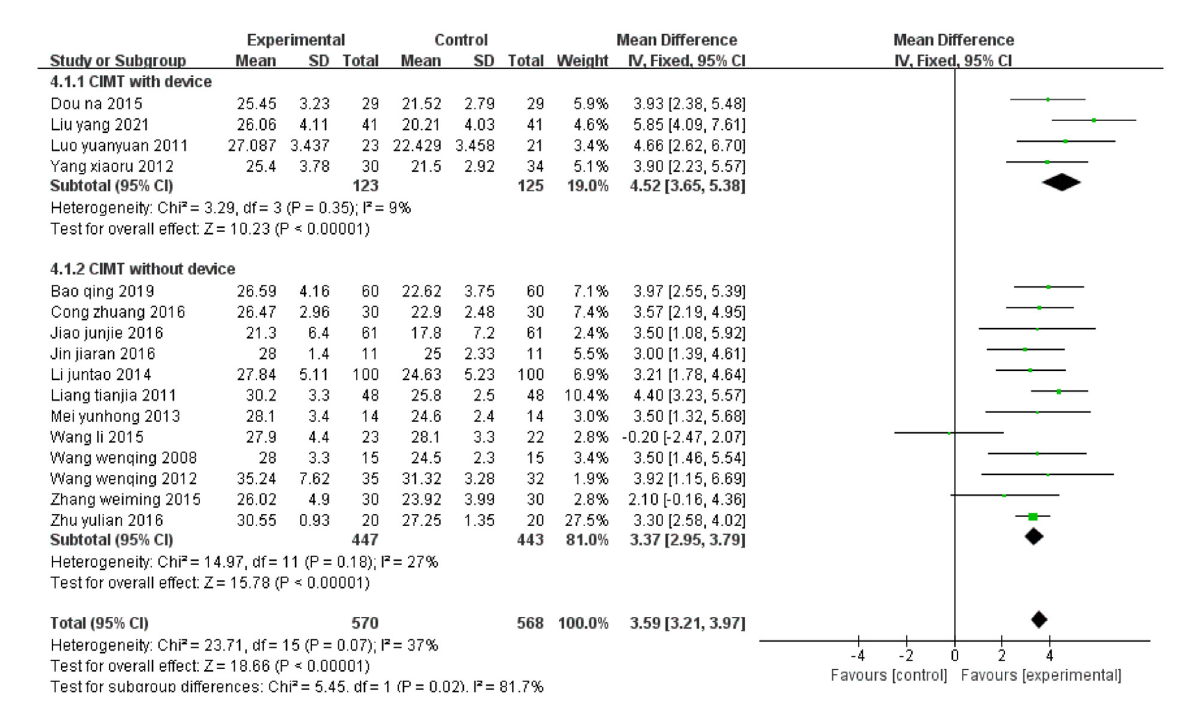
FIGURE14 Forest plot. CIMT with device vs. CIMT without device on the Fugl-Meyer Assessment lower limb sub-scale.